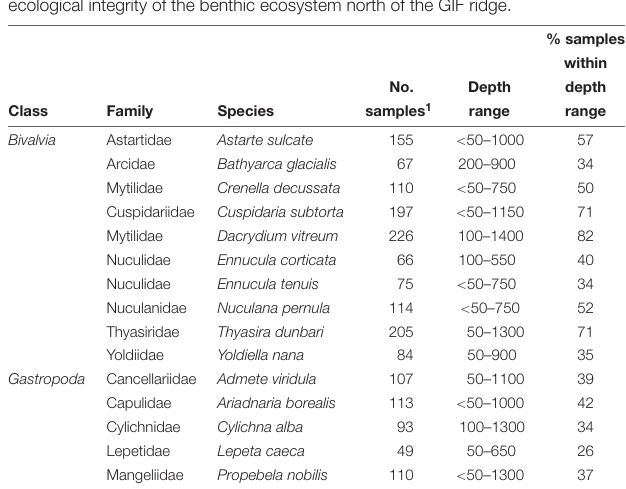
TABLE 3 | Bivalve and gastropod species that are suitable for monitoring ecological integrity of the benthic ecosystem north of the GIF ridge.